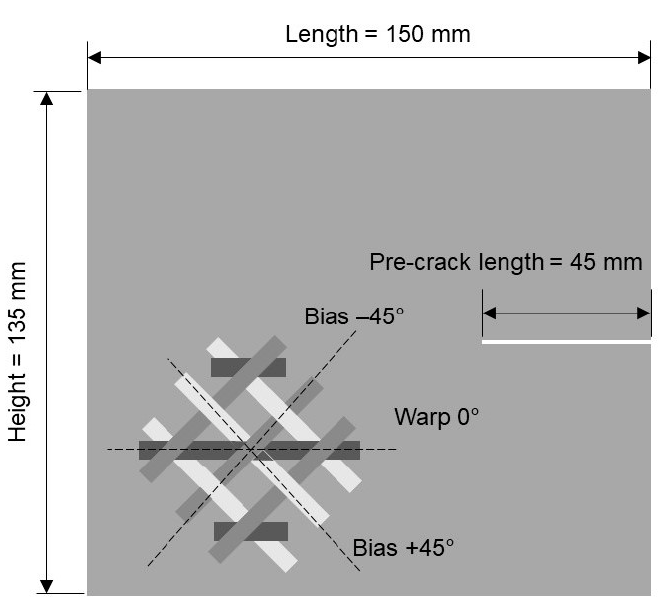
Figure 1. Schematic of the compact tension specimen.